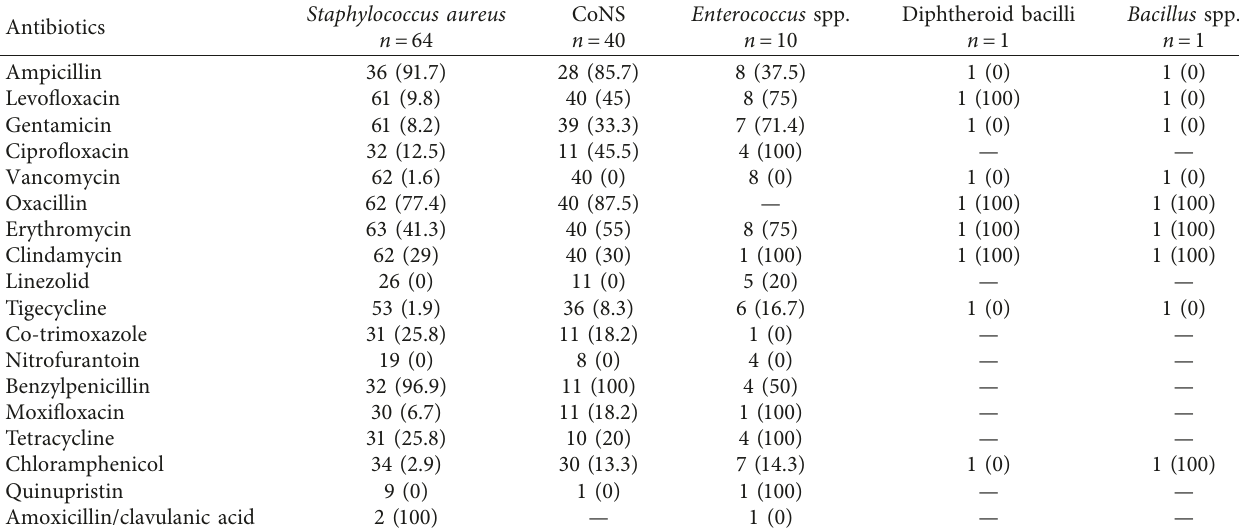
Table 3: Resistance pattern of gram-positive bacteria to antibiotic agents.